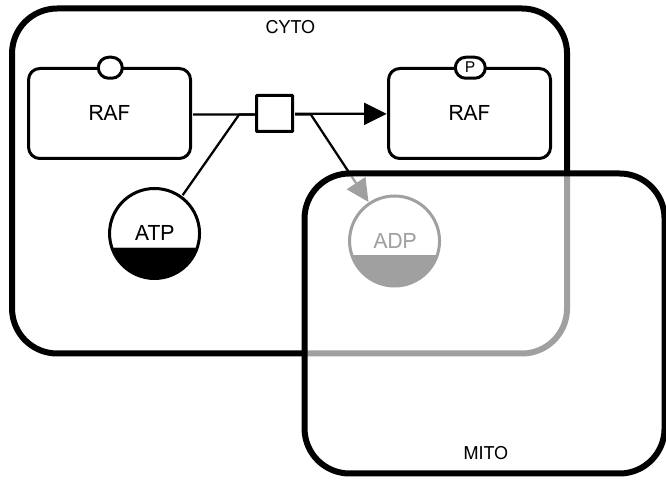
Figure 2.21: Example of an incorrect map. Overlapped compartments must not obscure other